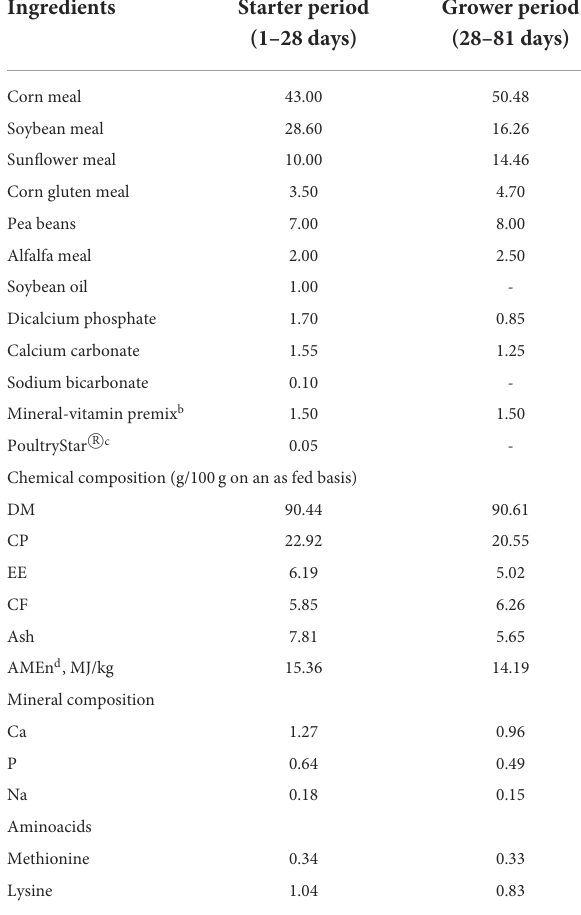
TABLE 1 Ingredients and the analyzed chemical composition of the experimental diets a .